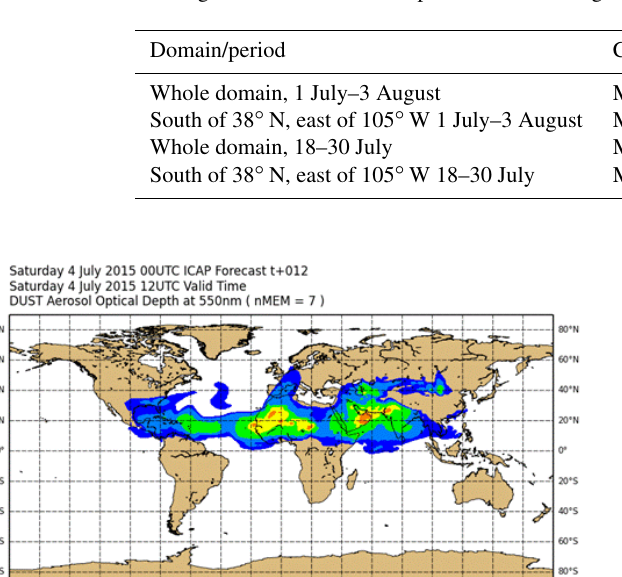
Table 2. Statistic results comparing CMAQ model results with EPA AIRNOW PM 2 . 5 . The mean bias (MB) and correlation ( R ) are calculated for the baseline run using static LBCs and the experimental run using NGAC LBCs.